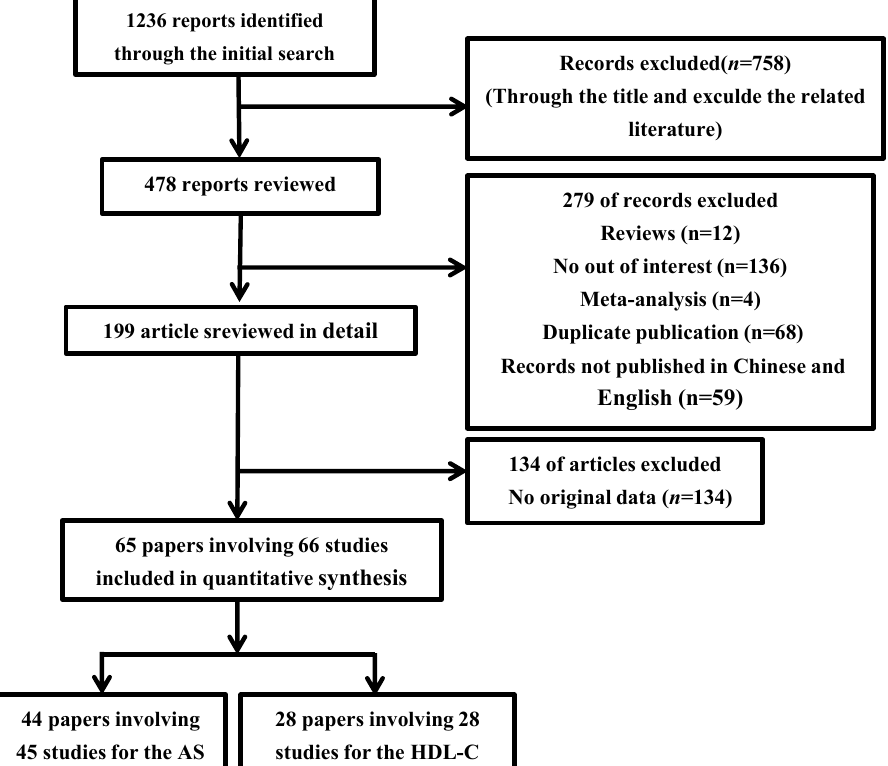
Figure 1. Flow diagram of the study selection process.